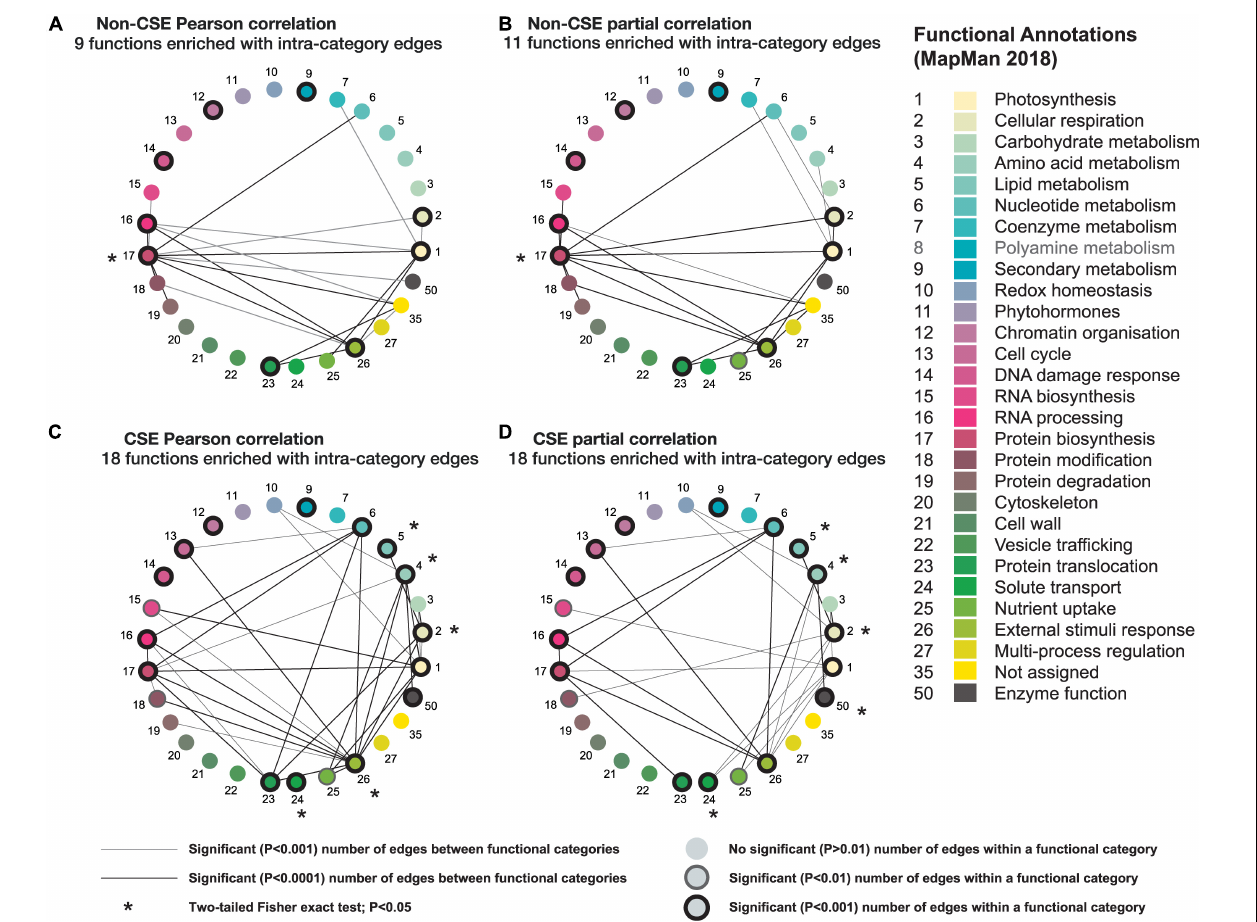
FIGURE 4 | Comparative analysis of four different correlation methods based on connectivity between different functional categories in mitochondria. Using newly updated MapMan annotations (MapMan X4 Release 1.0, 2018; Usadel et al., 2009), the mitochondrial set was subdivided into 29 different functional categories. Only functional categories with at least one significant ( P < 0.0001; one-tailed binomial test) connection to another category are displayed for each method. Nodes with a black outline indicate functional categories with significant ( P < 0.001) intra-connectivity, nodes with a faint outline indicates functional categories with significant ( P < 0.01) intra-connectivity, nodes lacking an outline indicates functional categories that do not have a significant ( P > 0.01) number of edges within a functional category. Lines between functional categories indicate a significant ( P < 0.0001) number of edges exist between the genes comprising both function categories. The presence of an * indicates that there is a significantly ( P < 0.05; two-tailed Fisher’s exact test) greater proportion of edges when comparing CSE-processed data vs. non-CSE data. (A) Non-CSE Pearson correlation, (B) non-CSE partial correlation, (C) CSE Pearson correlation, and (D) CSE partial